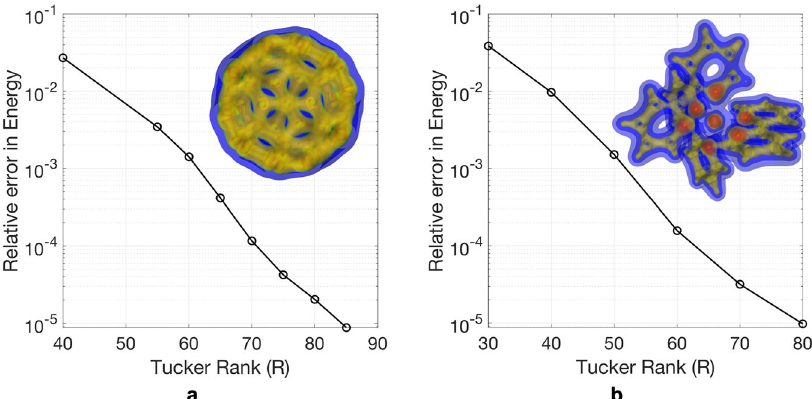
Fig. 4 Convergence with respect to the Tucker rank. a Fullerene and b Tris (bipyridine) ruthenium. The electron-density isocontours are provided in the